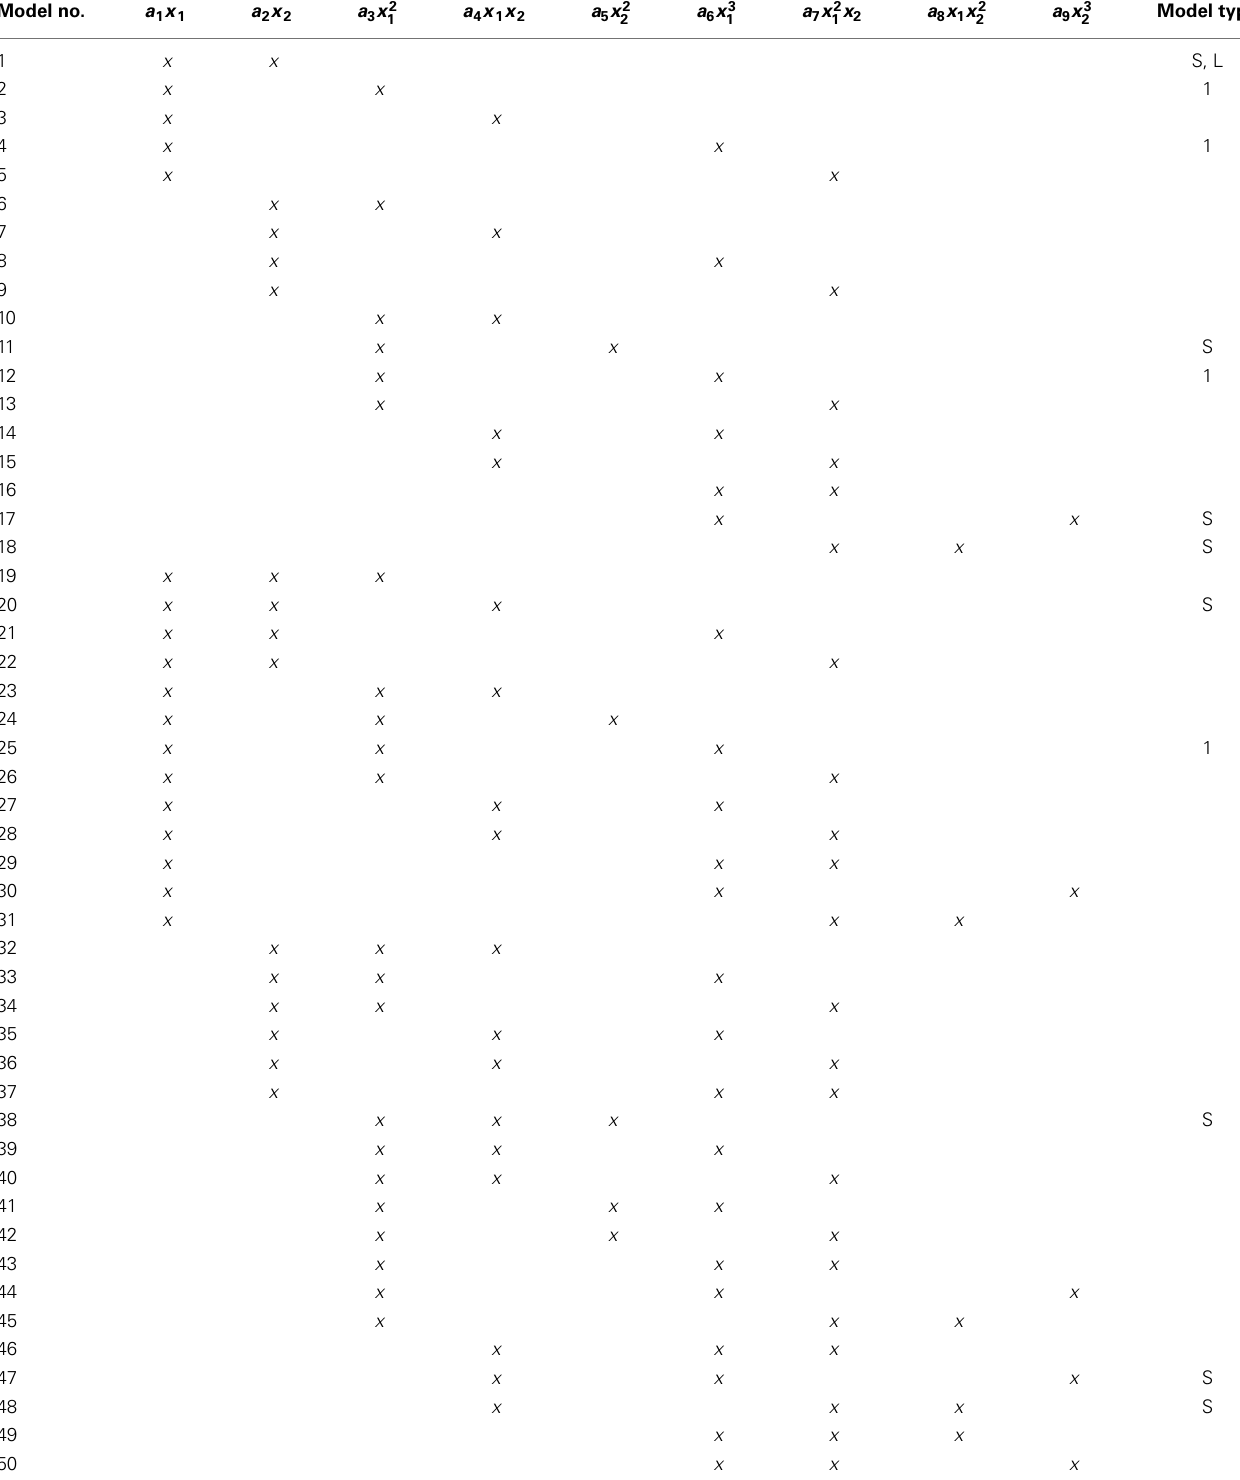
Table 1 |Two- and three-term